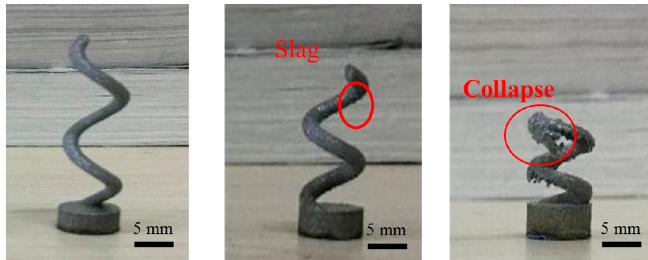
Figure 5. Manufacturing limits and surface finish of spiral structures with rising angle of 60°, 45° and 30°